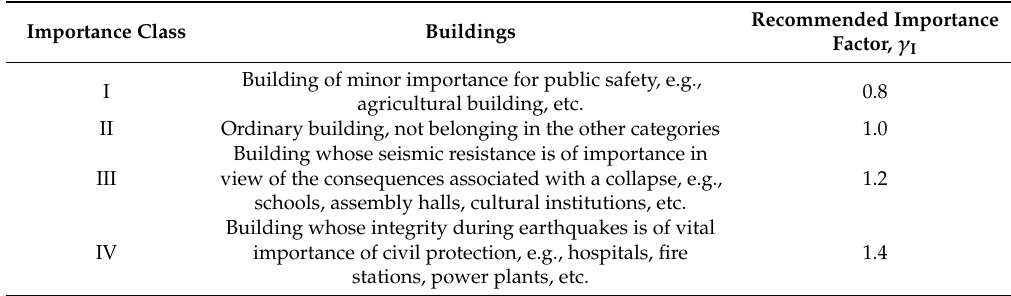
Figure 2. Ground acceleration map for ( a ) Vietnam [4] and ( b ) Hanoi.